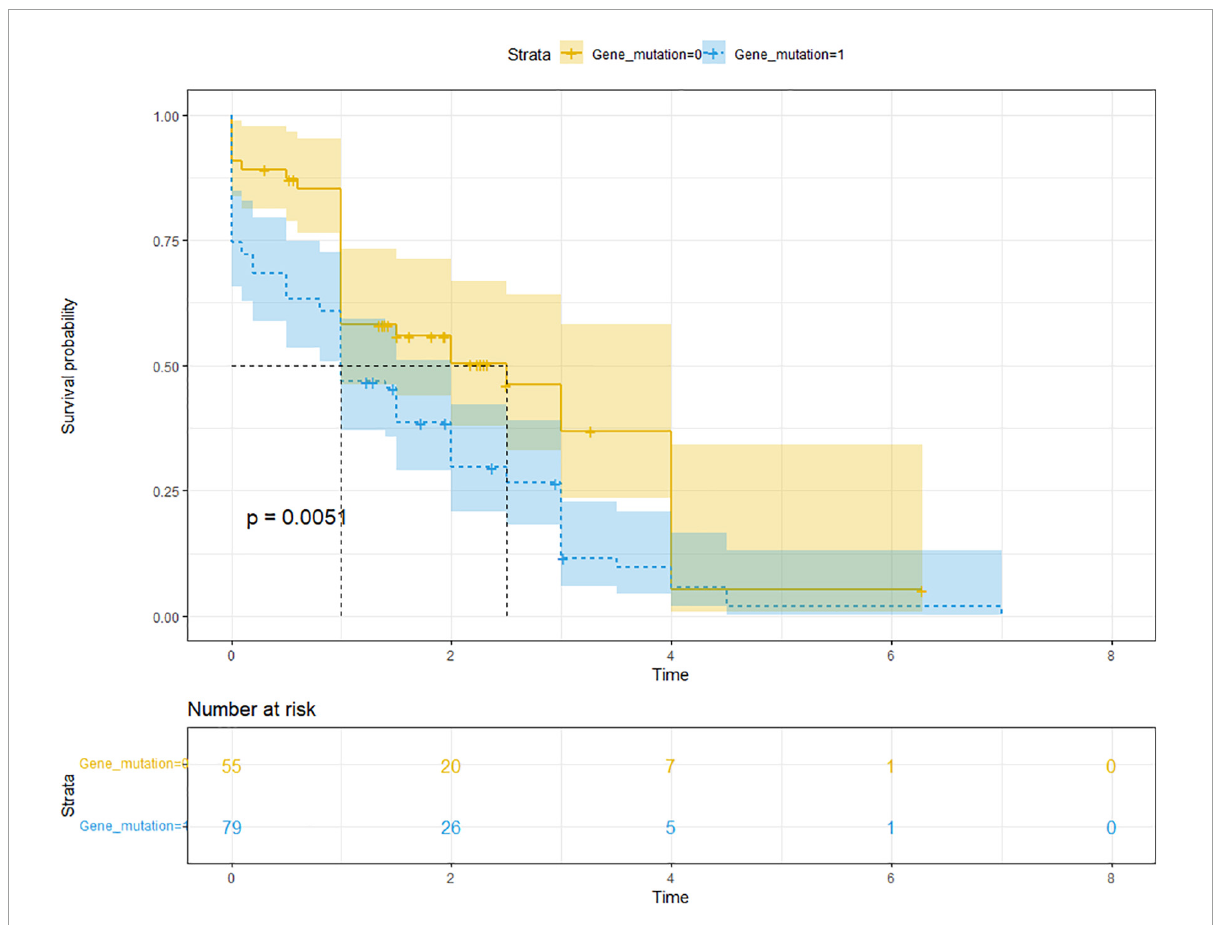
FIGURE1 Comparison of the Kaplan–Meier curves of CP progression between those with (blue) and without (yellow) gene mutations showed a significantly faster rate of progression from ARP to CP (HR of progression was 1.607; 95% CI: 1.024, 2.522; P = 0.039). Median time of progression to CP was 1.0 years for those with gene mutation and 2.5 years for those without gene mutations. HR, hazard ratio; CI, confidence interval.